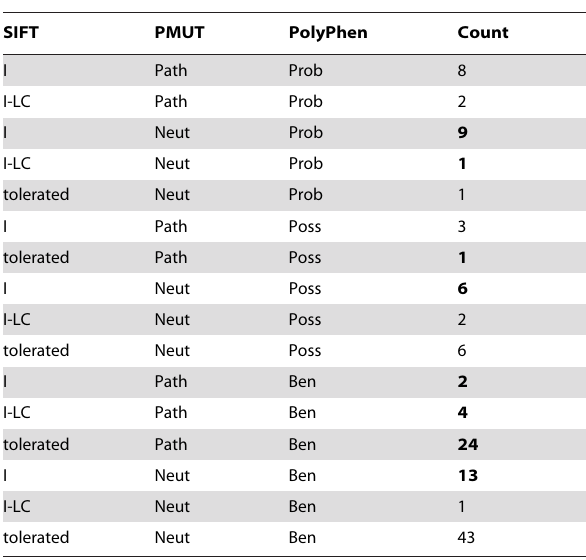
Table 1. Protein Function by